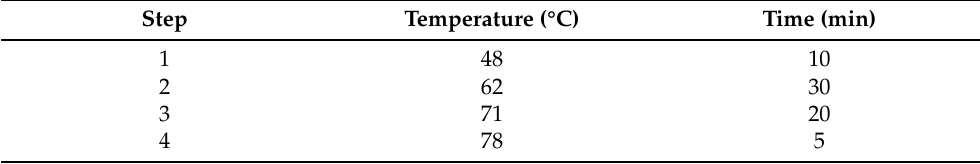
Table 1. Operating conditions of the scheduled mash steps: temperatures and